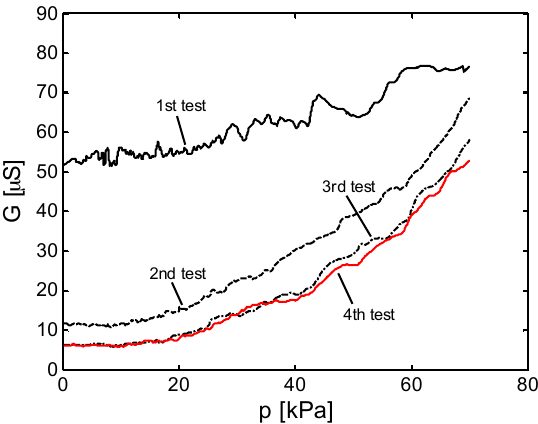
Figure 13. Mechanical stabilization of a MLG-F20 foam based pressure sensor: conductance G measured as function of applied pressure p during consecutive quasi-static monotonic loading tests.